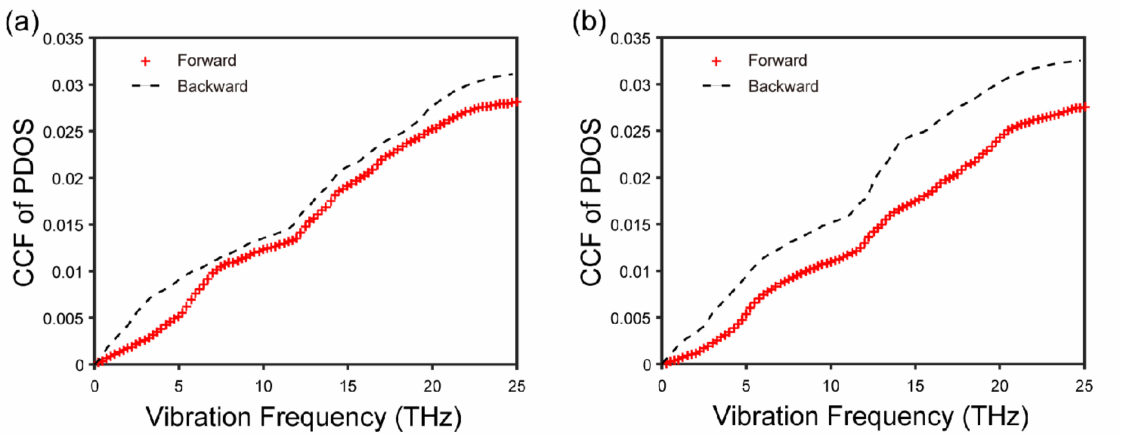
Figure 6. CCF of PDOS between C and BN atoms in the forward and backward direction. ( a ) Out-of-plane 25-nm-graphene/BN; ( b ) out-of-plane